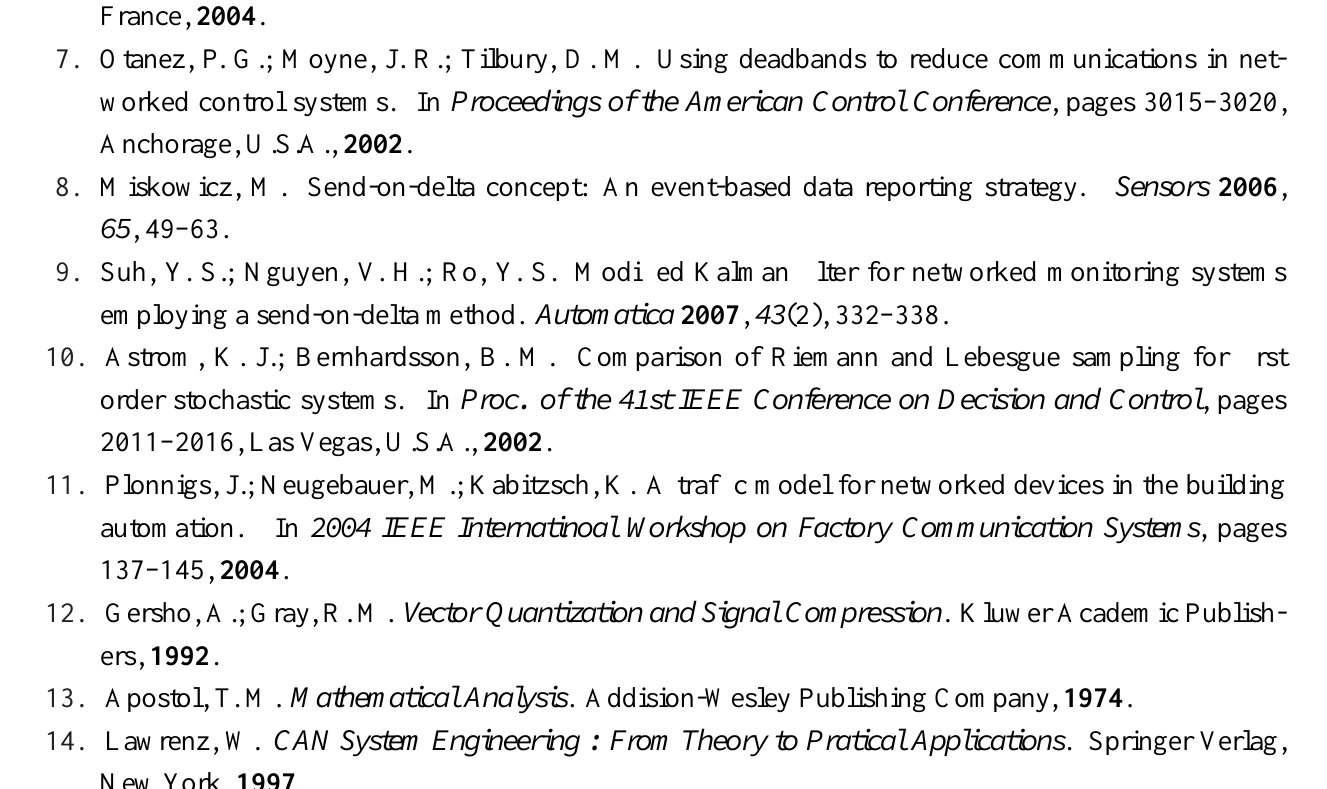
Figure 8 . Oscillation problem when only x Anchorage, U.S.A., 2001